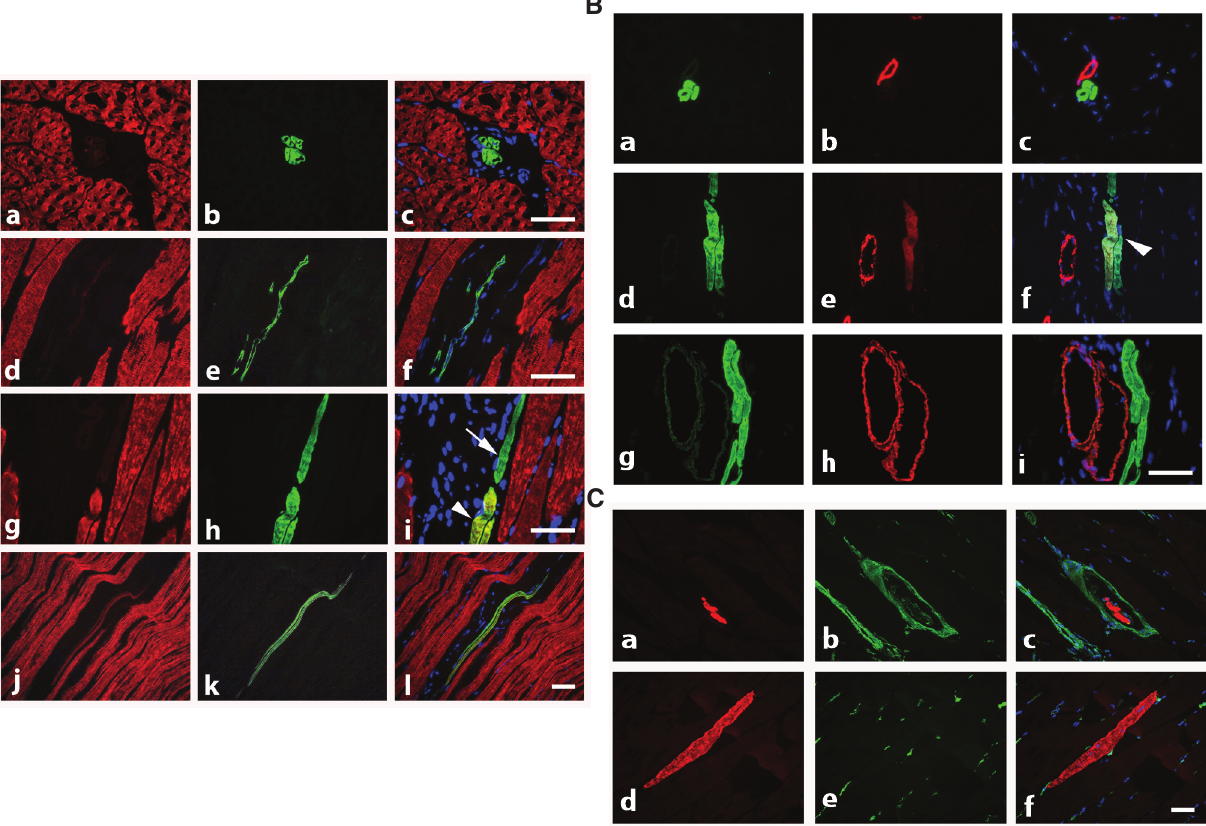
Figure 2. Rat adult skeletal muscle co-stained with isoform specific antibodies. A ) Co-staining with anti- α -SKA (red) and anti- α -CAA (green) allows the detection of isolated thin α -CAA positive fibers in interstitial connective tissue (transversal sections, a–c: longitudinal section, d–f) and of regenerating muscle fibers expressing both isoforms (longitudinal section, g–l, arrowhead), or only α -CAA (arrow). Merged images are shown on right column. Bars = 50 μm. B ) Co-staining with anti- α -CAA (green) and anti- α -SMA (red) shows that α -CAA positive spindle cells are in close connection with α -SMA positive vessel (a–c), that early muscle fiber self-regeneration is characterized by co-expression of both isoform (d–f, arrowhead), although more advanced regenerated fibers are only α -CAA positive (g–i). Merged images are shown on right column. Bar = 50 μm. C ) Co-staining with anti- α -CAA (red) and anti-vimentin (green) allows the detection of α -CAA positive muscle spindle cells surrounded by a capsule containing vimentin positive cells (transversal section, a–c) and of regenerating α -CAA positive fibers in contact with vimentin positive cells (longitudinal section, d–f). Merged images are shown on right column. Bar = 50 μm.